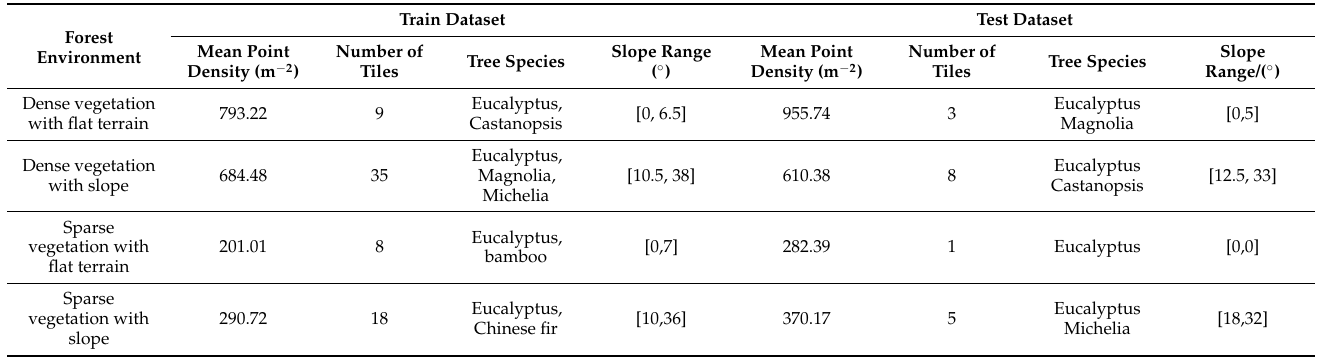
Table A1. Description of the UAV LiDAR dataset.